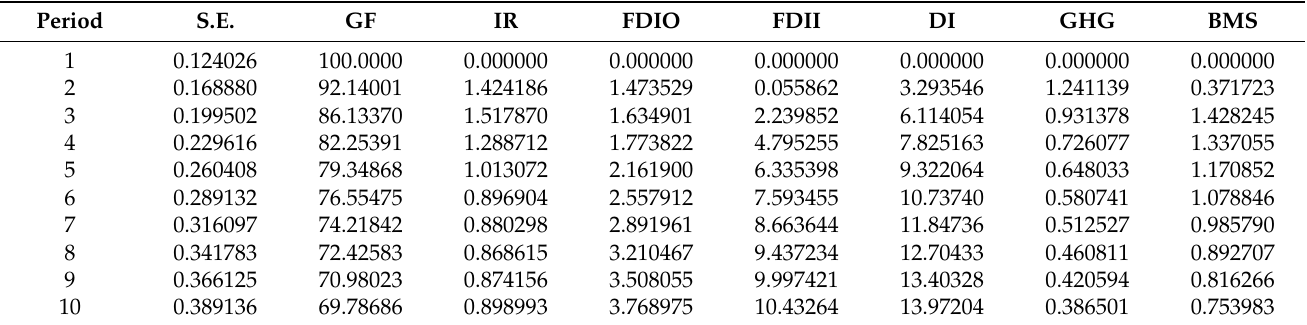
Table 6. Variance decomposition of green